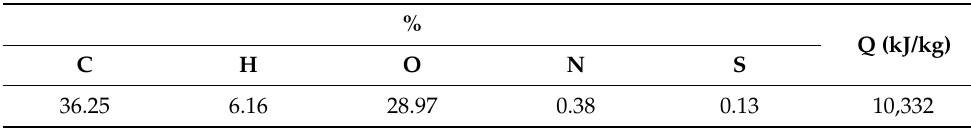
Table 1. The designed biomass fuel